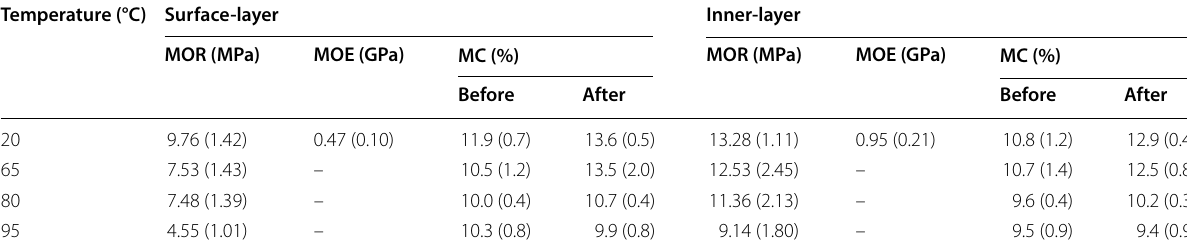
Table 2 Average MOR, MOE, and MC of the specimen before and after rupture load test